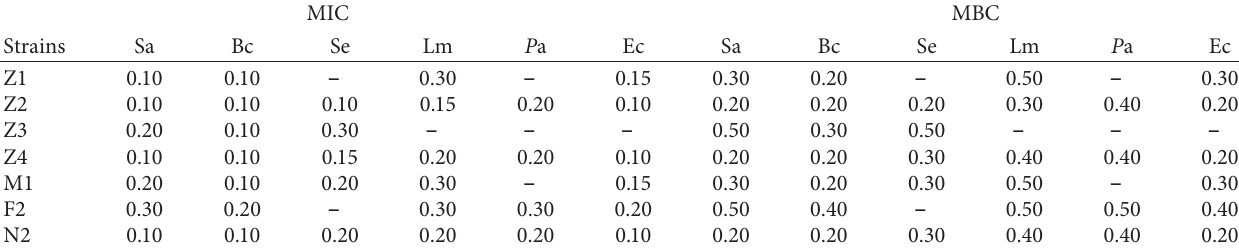
Table 7: The MIC and MBC of broad-spectrum extracts of LAB strains ( µ g/ µ L) against food spoilage and pathogenic bacterial strains. MIC MBC Strains Sa Bc